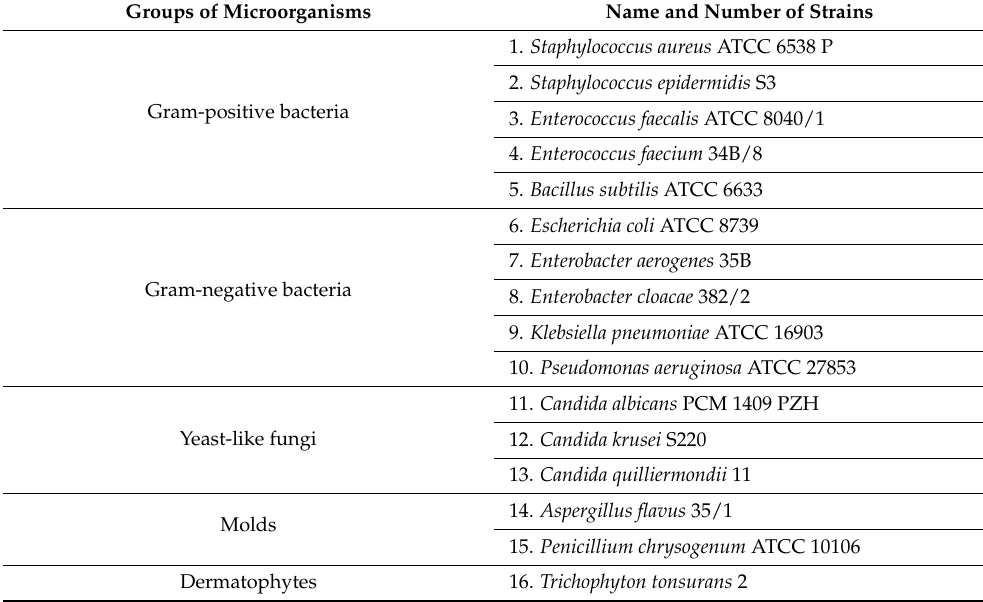
Table 6. Microbial strains used in antimicrobial tests of the methanol extracts from the biomass of in vitro cultures of the H. perforatum cultivars Helos, Elixir, and Topas. Groups of